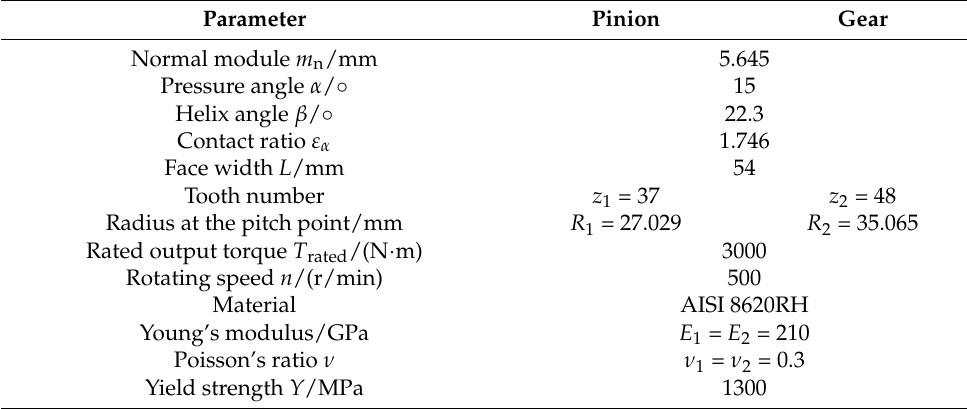
Figure 3. ( a ) The meshing gear pair in a heavy loader gearbox and ( b ) the simplified contact model. Table 1. Gear pair parameters.